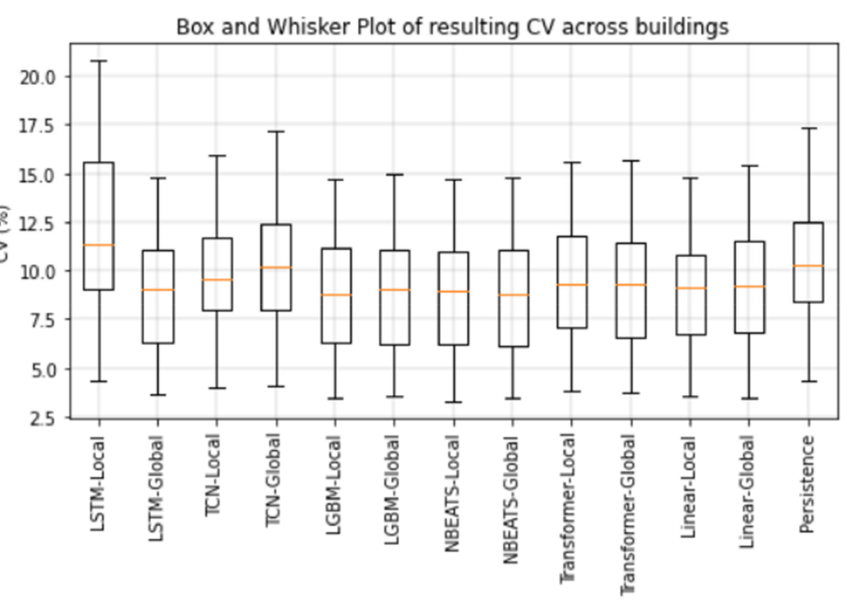
Figure 16. Comparison between the CV obtained from the considered local and global models on test set. The Persistence model has been added as a